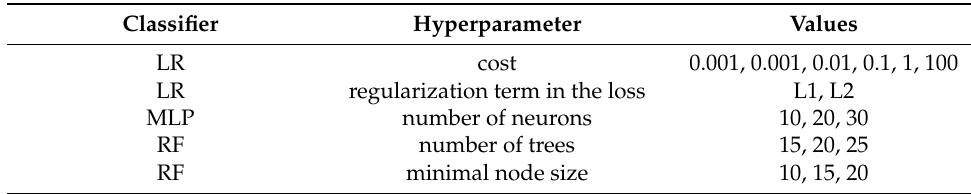
Table 2. Machine learning models and